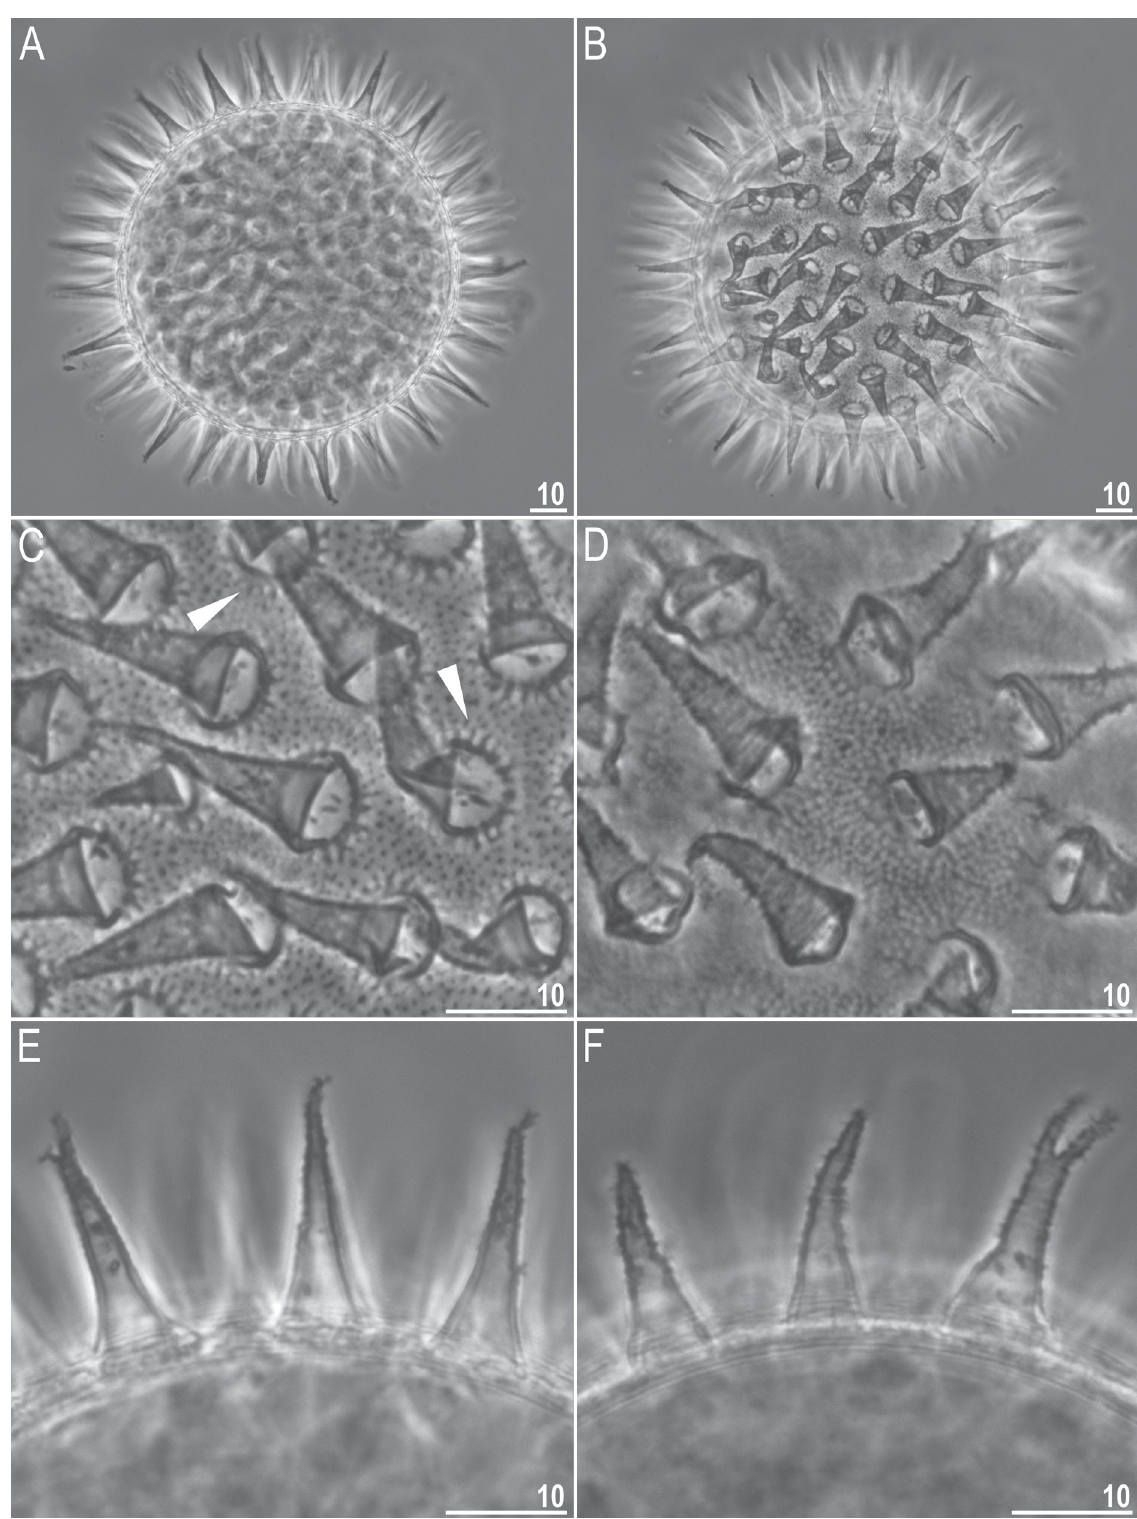
Fig. 13. Macrobiotus cf. recens Cuénot, 1932 , Gran Canaria, egg seen under PCM. A . Midsection under 400 × magnification. B . Surface under 400 × magnification. C–D . Surface under 1000 × magnification. E – F . Midsection under 1000 × magnification. Filled arrowheads indicate short thickenings radiating from the processes bases. Scale bars in